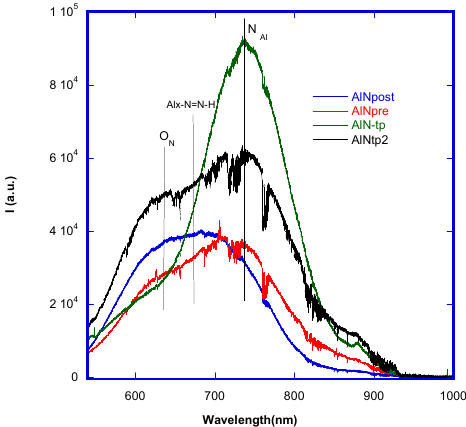
Figure 5. AlN thin-film photoluminescence spectra before (AlN pre and AlN tp ) and after (AlN post and AlN tp2 ) annealing at 580 °C.